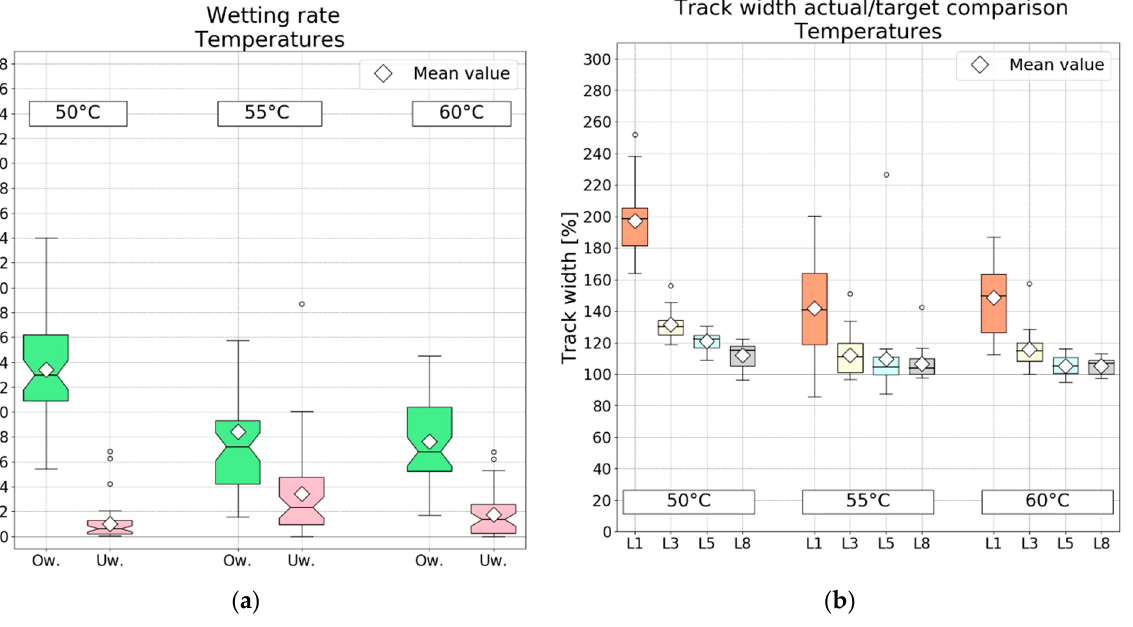
Figure 12. Boxplot diagrams of ( a ) Wetting rates, including overwetting and underwetting and ( b ) track width actual/target comparison for different line widths with varying substrate temperatures.